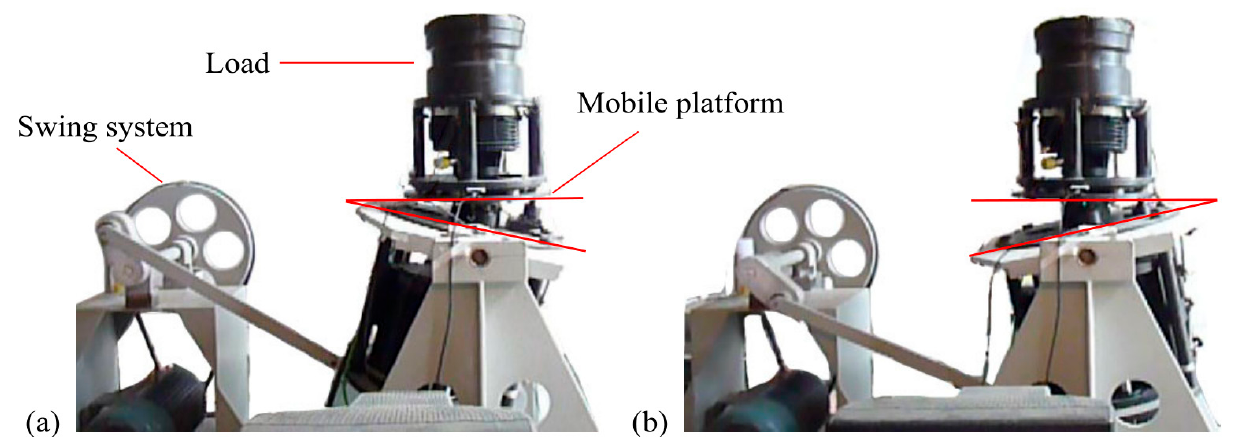
Figure 8. Maximum angle leveling state. ( a ) The maximum angle generated at the farthest end of the swing system. ( b ) The maximum angle generated at the closest end of the swing system.